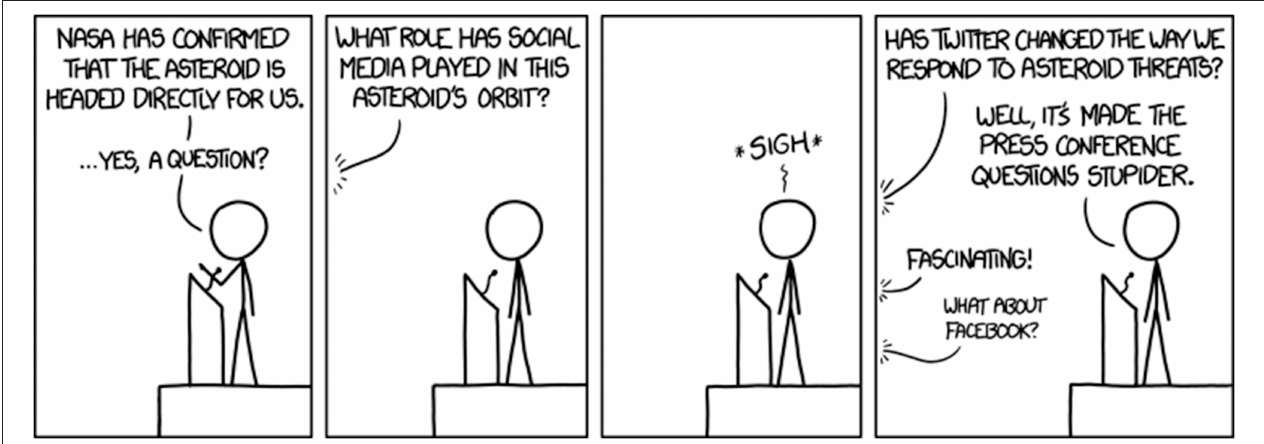
FIGURE 1 | Social Media: an illustration of overstimating the relevance of social media to social events from XKCD. Available online at http://xkcd.com/ 1239/ (Accessed June 16, 2016).